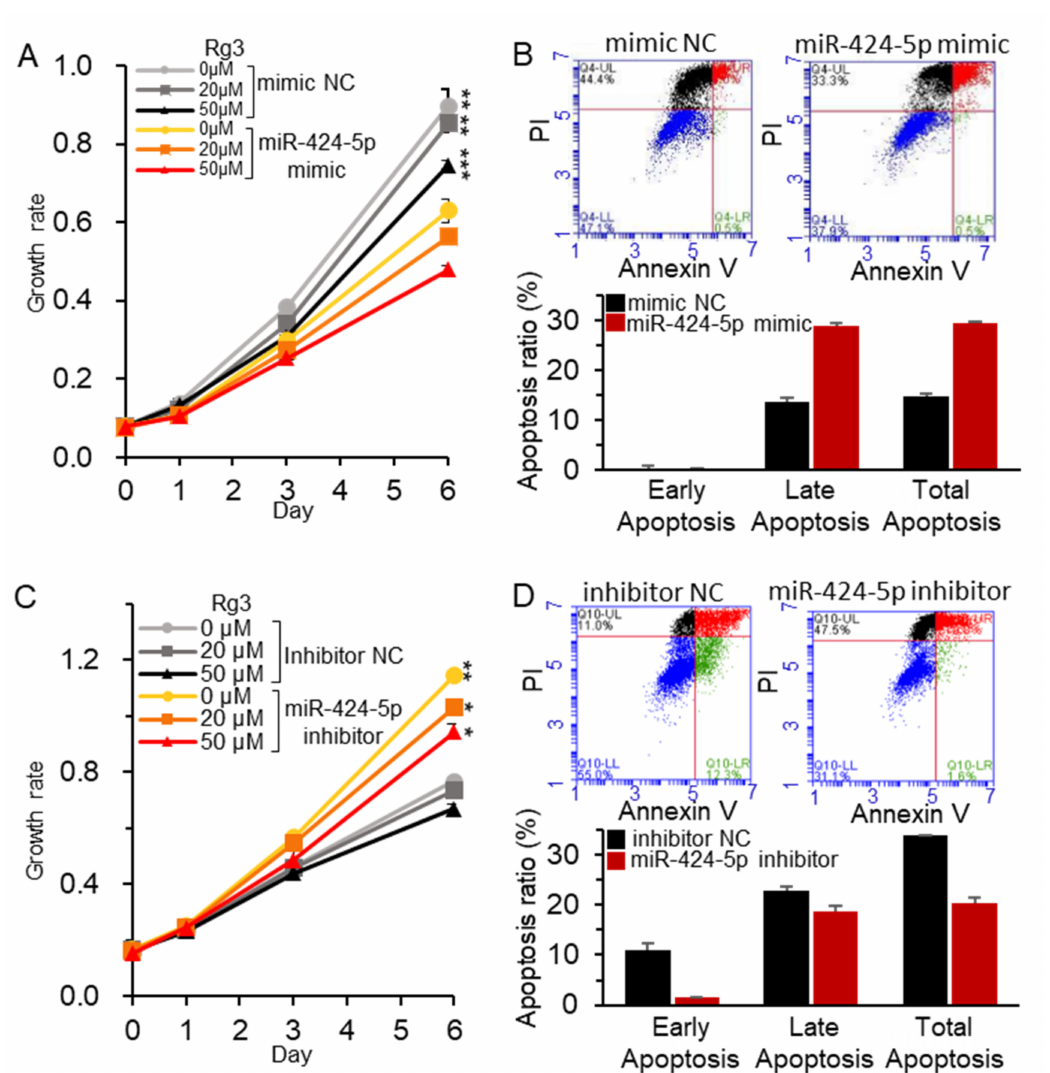
Figure 3. MiR-424-5p inhibited MCF-7 cell proliferation. MiR-424-5p was deregulated in MCF-7 by transiently transfecting the cells with a mimic ( A , B ) or an inhibitor ( C , D ), after which cell proliferation and apoptosis were assessed with the CCK-8 assay and flow-cytometry analysis. Rg3 was coadministered with the mimic (40 µ M) or inhibitor (20 µ M) for the proliferation assay. Testing was done using mimic NC, negative control miR-424-5p mimic (40 µ M) and inhibitor NC, negative control inhibitor for miR-424-5p (20 µ M). All experiments were performed in triplicate, and the results are presented as the mean ± SE. Representative images are shown for flow-cytometry analysis. * p < 0.05, ** p < 0.01, *** p <